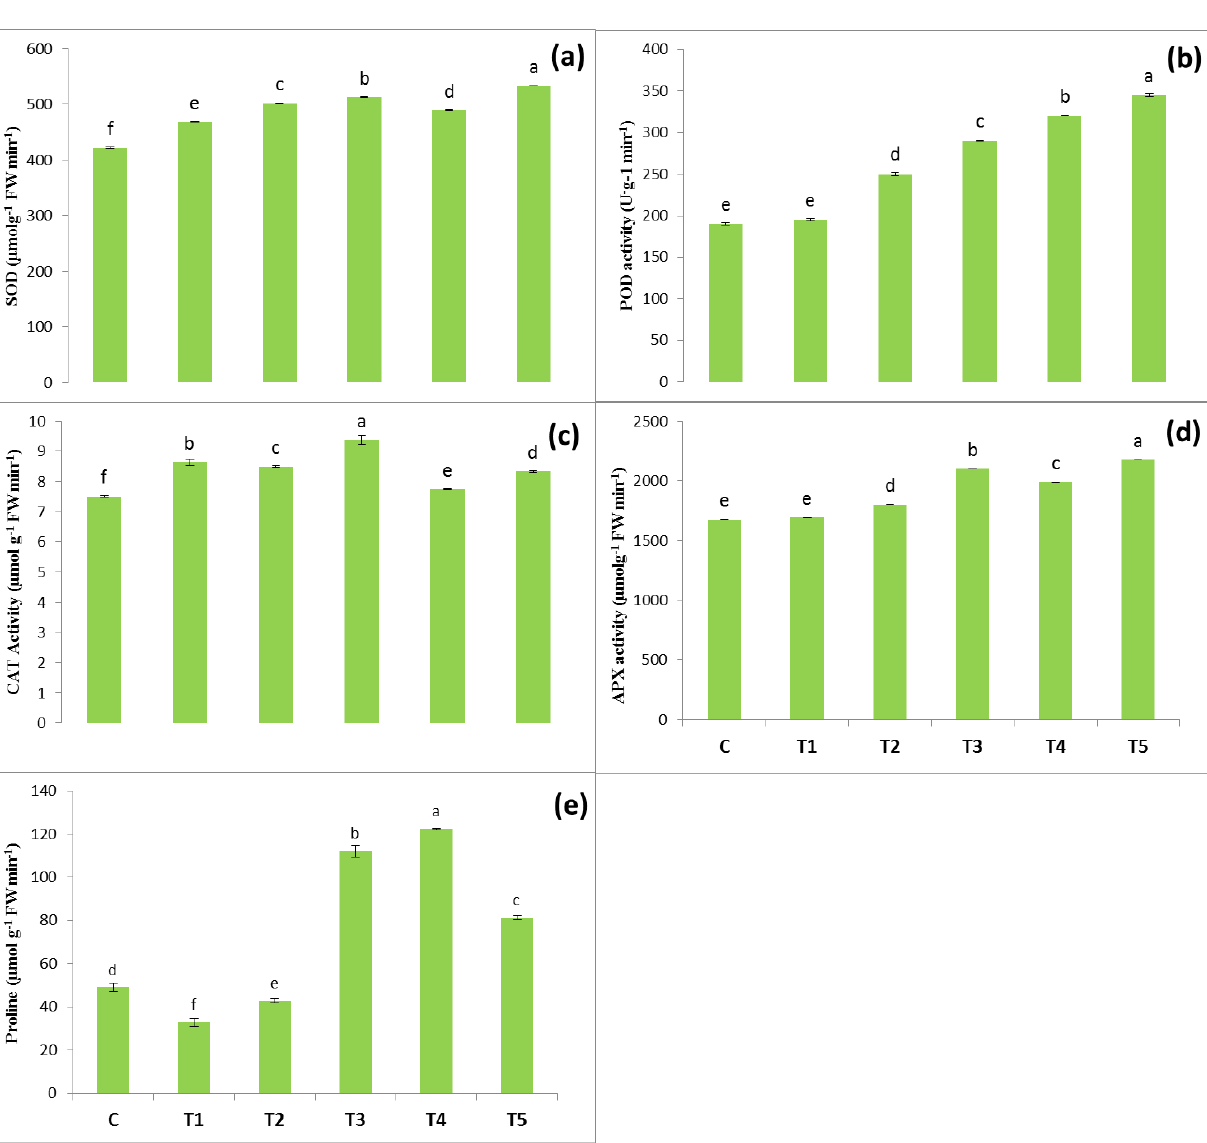
Figure 3. Activities of SOD ( a ), POD ( b ), CAT ( c ), APX ( d ), and proline ( e ) in the leaves of A. rosea at different Cd treatments single or in synergy with CA. Vertical bars indicate mean ± standard deviation. Where T1 = 5 mM · kg − 1 CA, T2 = 100 mg · kg − 1 Cd, T3 = 100 mg · kg − 1 + 5 mM · kg − 1 , T4 = 200 mg · kg − 1 Cd, and T5 = 200 mg · kg − 1 + 5 mM · kg − 1 . Different lowercase letters represent significant differences between the treatments at p <